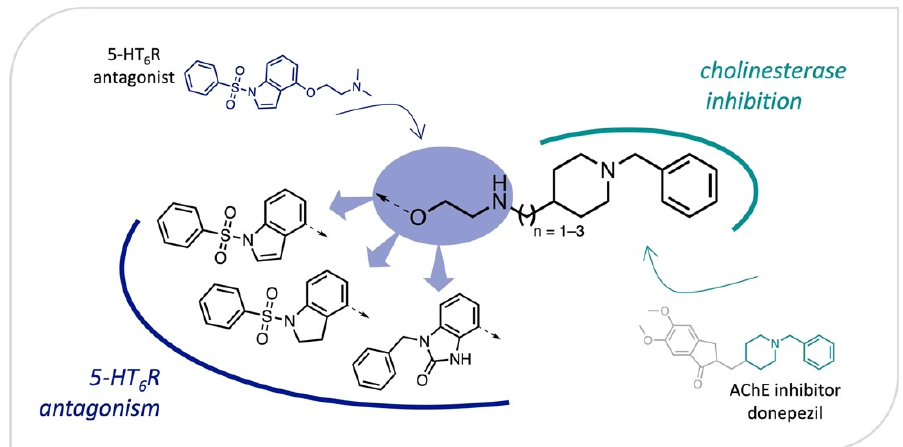
Figure 1. Design of new multifunctional ligands derived from AChE inhibitor—donepezil and 5- HT 6 antagonists.